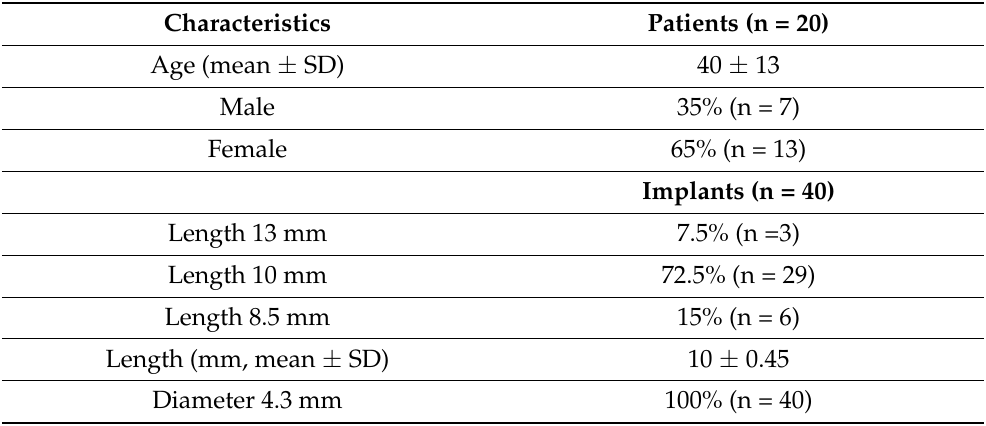
Table 1. Relevant data regarding patients’ population and implant